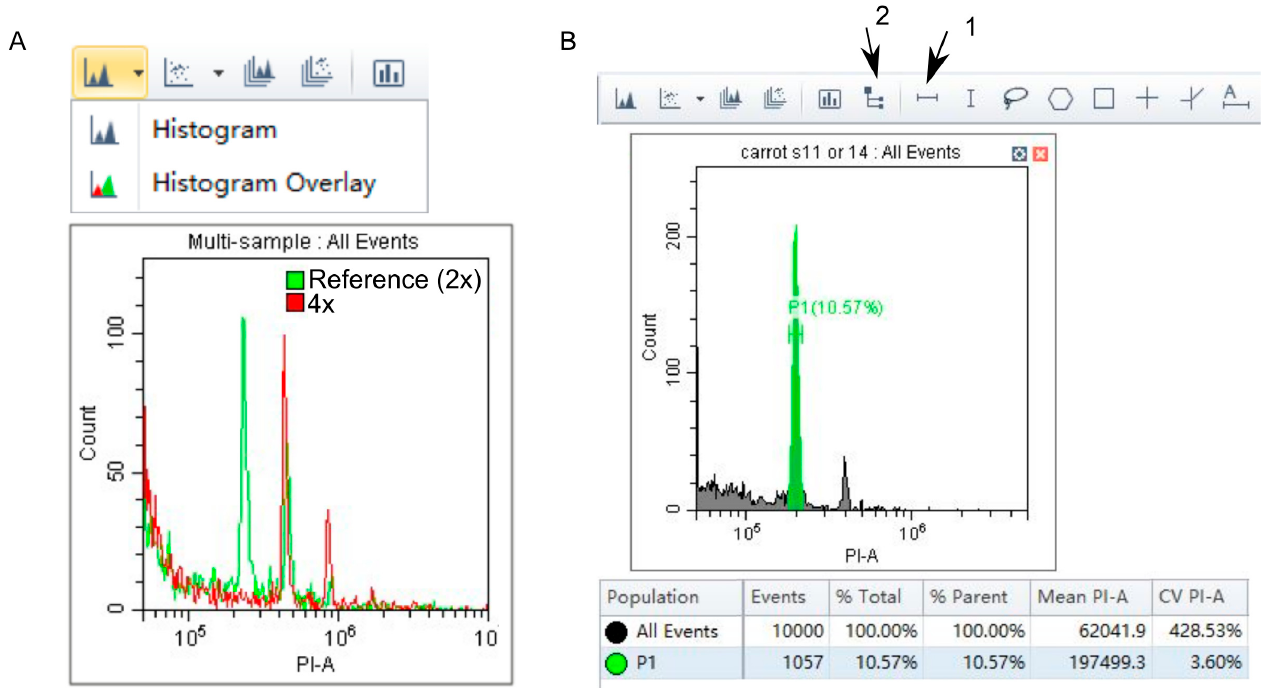
Figure 2. Flow cytometry data analysis. ( A ). The ploidy of summer squash ( Cucurbita pepo L. subsp. pepo ) regenerant produced by doubled haploid technology was analyzed. Seed-derived summer squash leaves were used as a reference standard. Nuclei were isolated by razor chopping in Galbraith buffer and stained with PI. Reference standard (2×) histogram (green) was overlaid with the regenerant histogram (red). The regenerant G 0 /G 1 peak overlays with reference G 2 peak. Hence, the regenerant is a tetraploid plant (4×). ( B ). Create G 0 /G 1 peak population (P1) using the tool (1). Create statistics window (shown below the plot) using the tool (2). Click on statistics window, pick mean and CV values to be displayed.